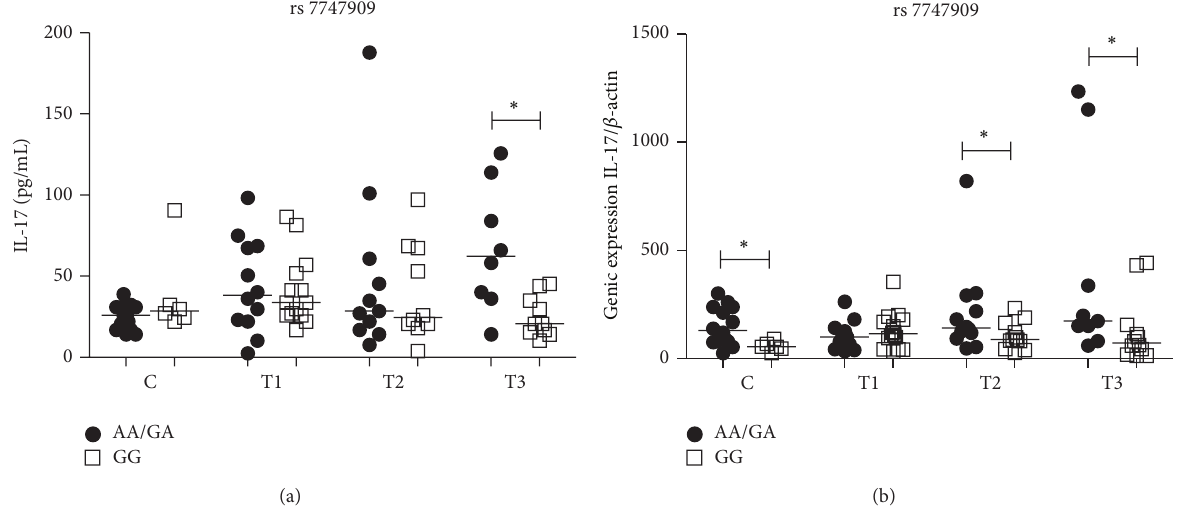
Figure 5: Influence of IL17 SNP rs7747909 on IL-17 plasma levels (a) and mRNA expression (b) in the control group (C) and PTB patients group at three time points of the treatment: T1 (after diagnosis and first month), T2 (three months), and T3 (six months). Data are shown as median levels. ∗ 𝑃 < 0.05